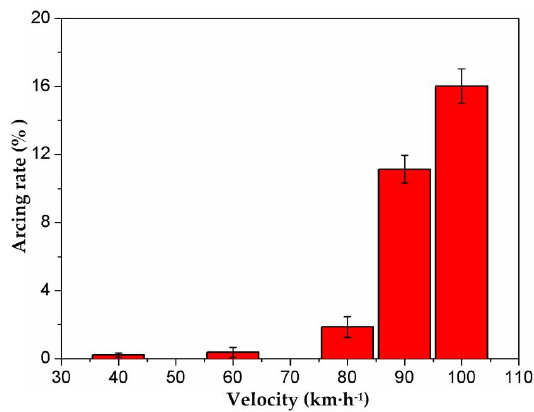
Figure 4. Arcing rate of the pure carbon strip varying with velocity.